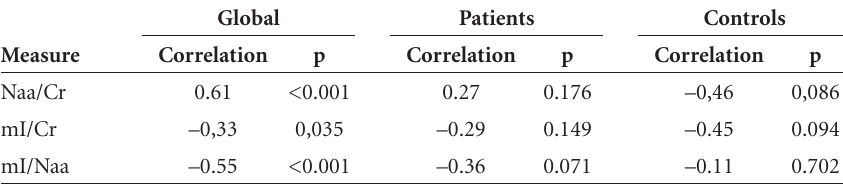
Table 2. Association between MMSE and ratios among metabolites.